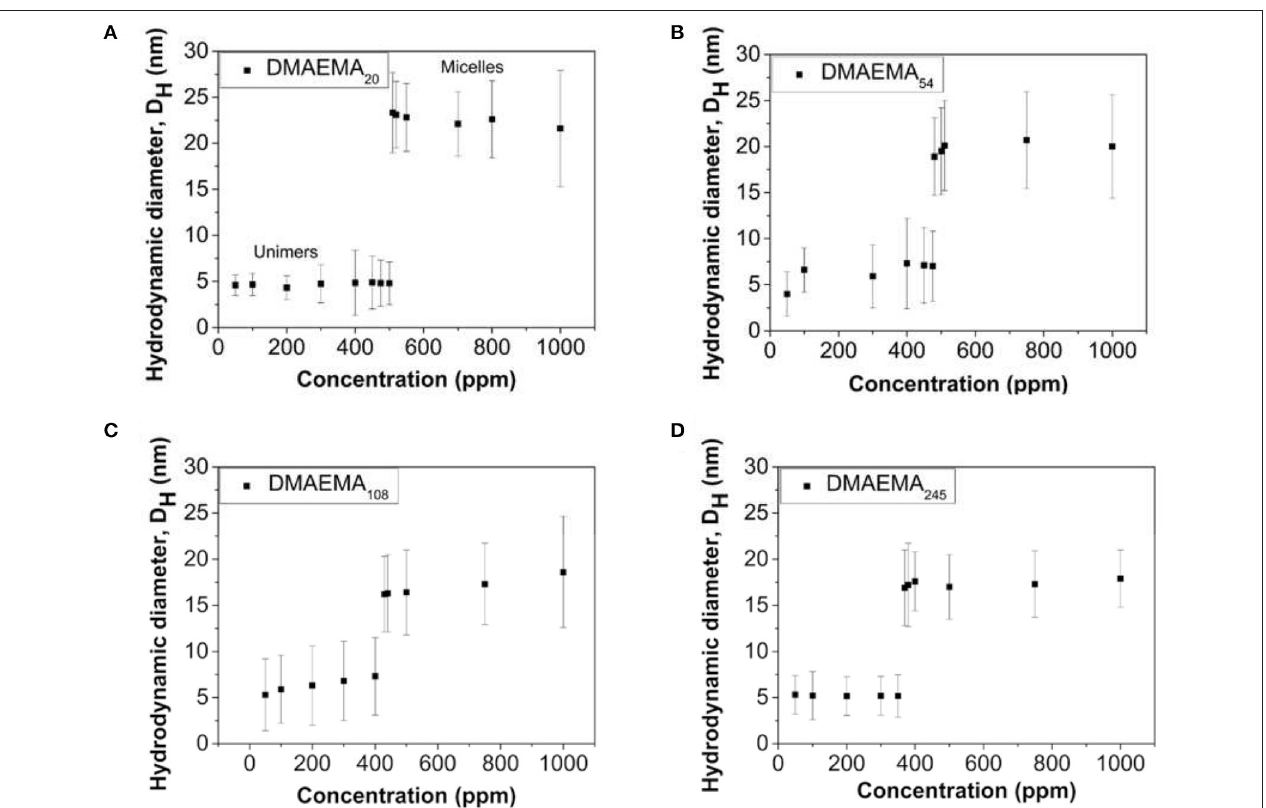
FIGURE 1 | Variation in the diblock copolymer (or the formed micellar aggregates) hydrodynamic diameter as a function of polymer concentration for four different DMAEMA block lengths; (A) 20, (B) 54, (C) 108, and (D) 245. The polymer solutions are prepared at pH 4 in the presence of 0.01M KNO 3 ( T = 25 ◦